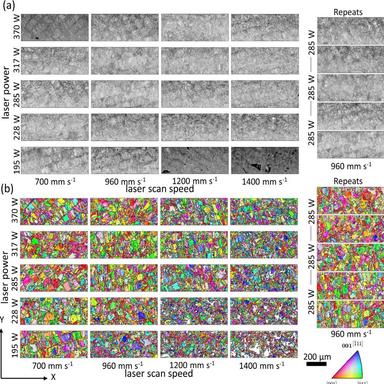
EBSD (a) band contrast and (b) inverse pole figure maps of as-built combinatorial sample. The field of view for each micrograph is approximately 0.948 mm 0.354 mm. The scale bar applies for all images.